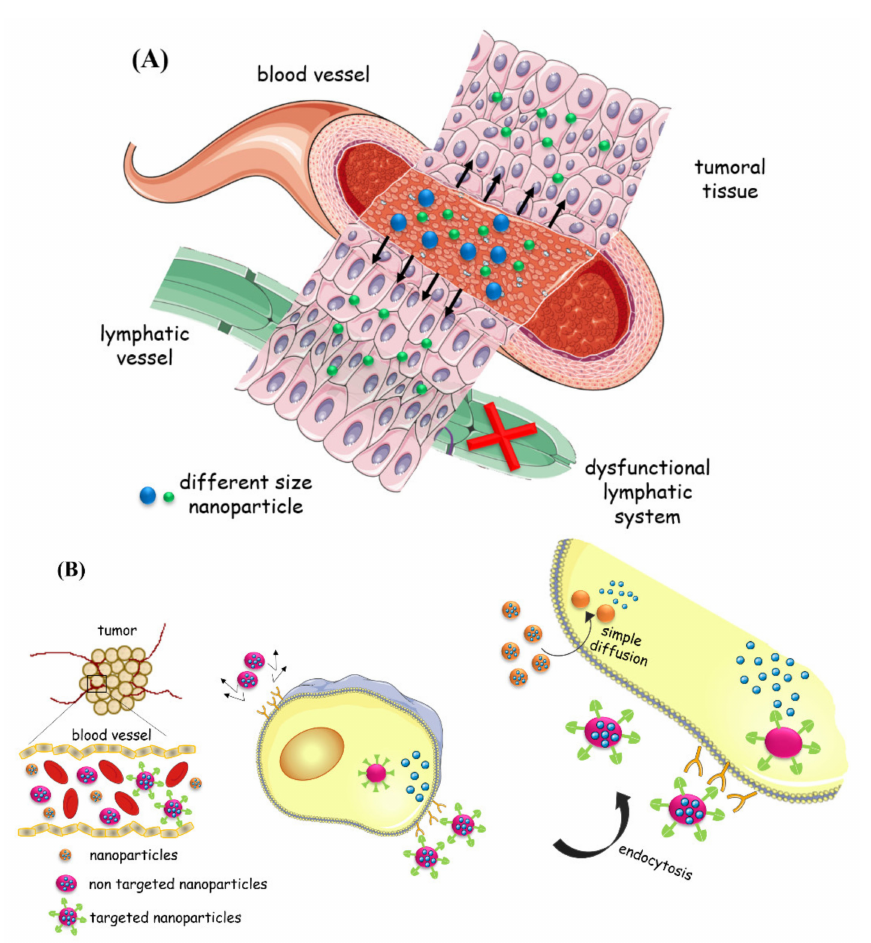
Figure 1. ( A ) Enhanced permeability and retention effect; ( B ) Passive (simple diffusion) and active targeting (endocytosis) of